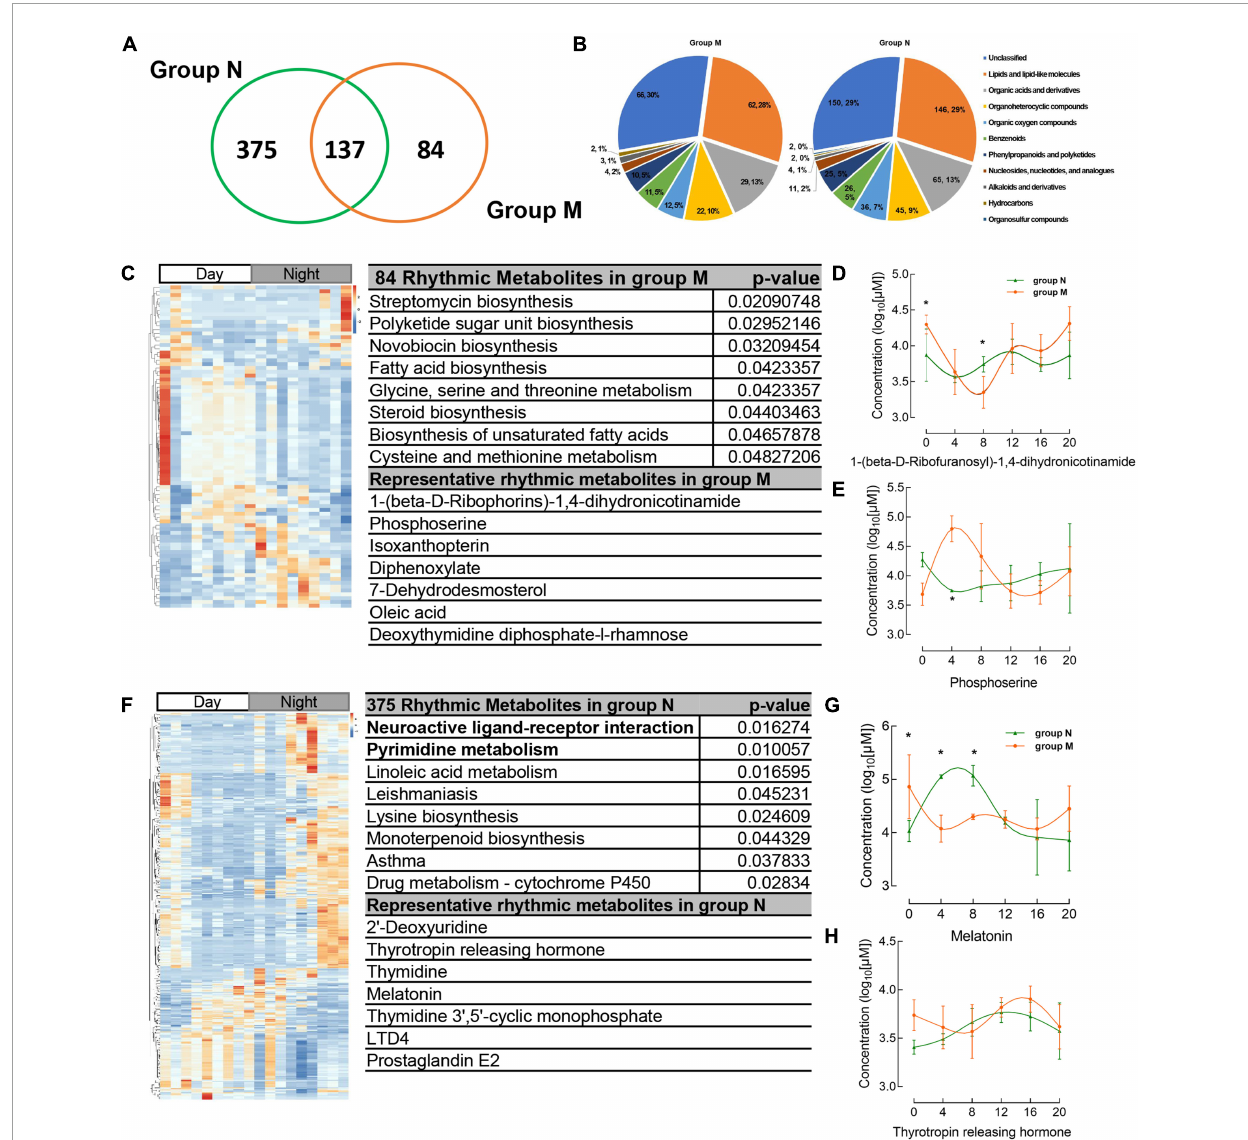
FIGURE3 Circadian rhythmic metabolites were identified from salivary samples. (A) The number of saliva metabolites with circadian rhythm (adj. p < 0.05) is shown as a Venn diagram. (B) The major classes of salivary metabolites with circadian rhythm. (C) Heatmap of 84 rhythmic metabolites which show only rhythm in group M and their KEGG enrichment pathway, representative metabolites in the chart. (D,E) The concentration of representative metabolites 1-(beta-D-ribophorins)-1,4-dihydronicotinamide, phosphoserine. (F) The metabolites which disappear rhythmicity in MPASD mean that only rhythmic in group N and KEGG enrichment and representative metabolites. (G,H) The concentration of representative rhythmic metabolites melatonin and thyrotropin releasing hormone. * p <